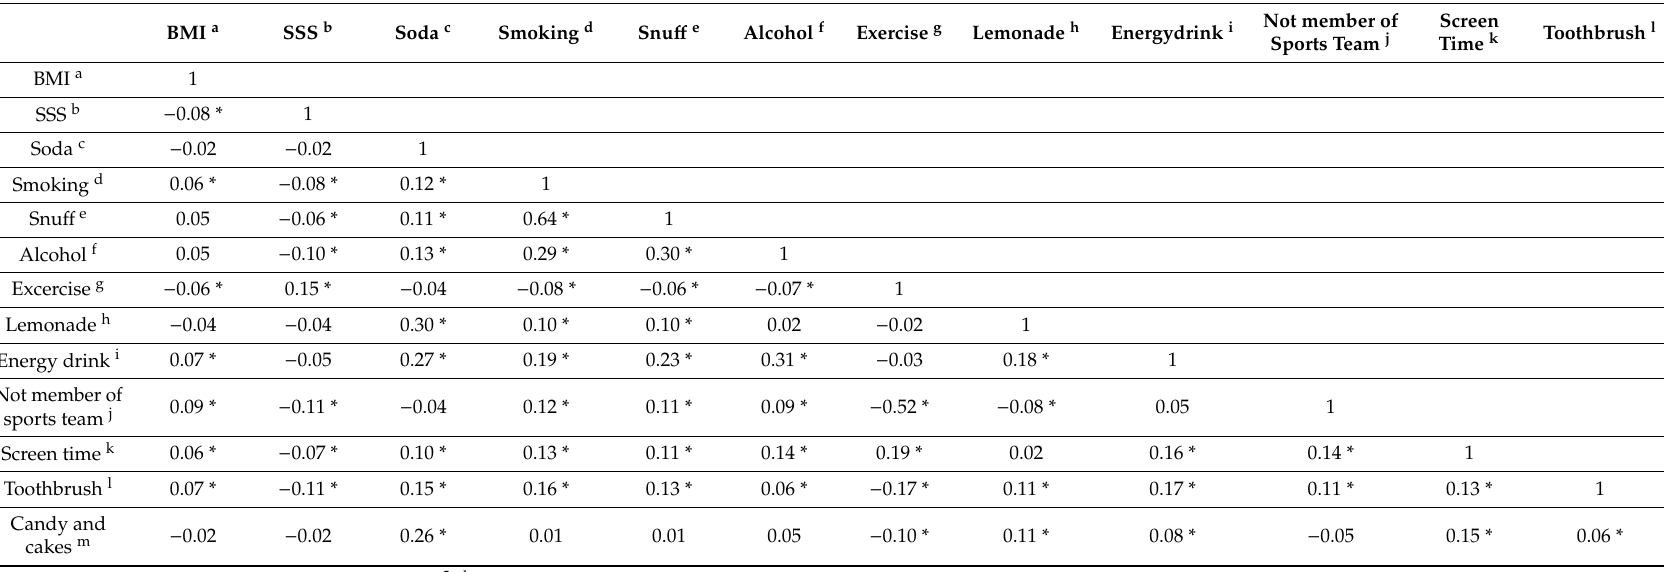
Table A2. Spearman’s correlation coe ffi cient (rho) for all variables explored during the model-building in the SEM for the 2017 survey, n = 1377. BMI a SSS b Soda c Smoking d Snu ff e Alcohol f Exercise g Lemonade h Energydrink i